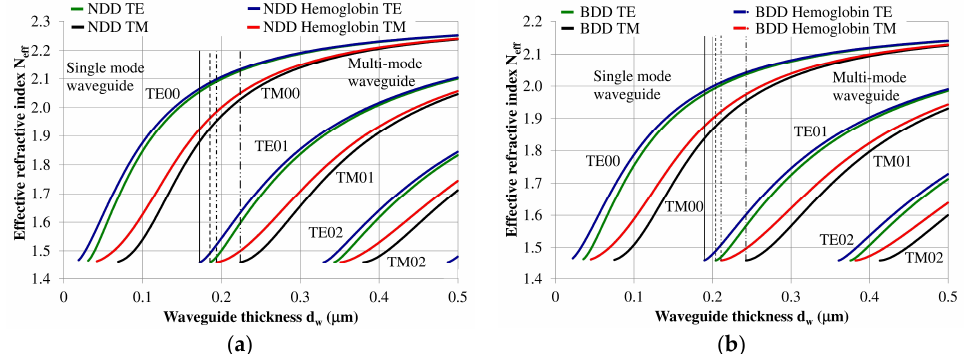
Figure 3. Modal characteristics of waveguide structure based on: ( a ) undoped diamond waveguide layer, ( b ) boron-doped diamond waveguide layer. The following vertical lines indicate the border between single or multi-mode propagation: solid line: waveguide structure with hemoglobin cover layer (TE polarization), dashed line: waveguide structure without hemoglobin cover (TE polarization), dashed line with a single dot: waveguide structure with hemoglobin cover layer (TM polarization), dashed line with a double dot: waveguide structure without hemoglobin cover layer (TM polarization).